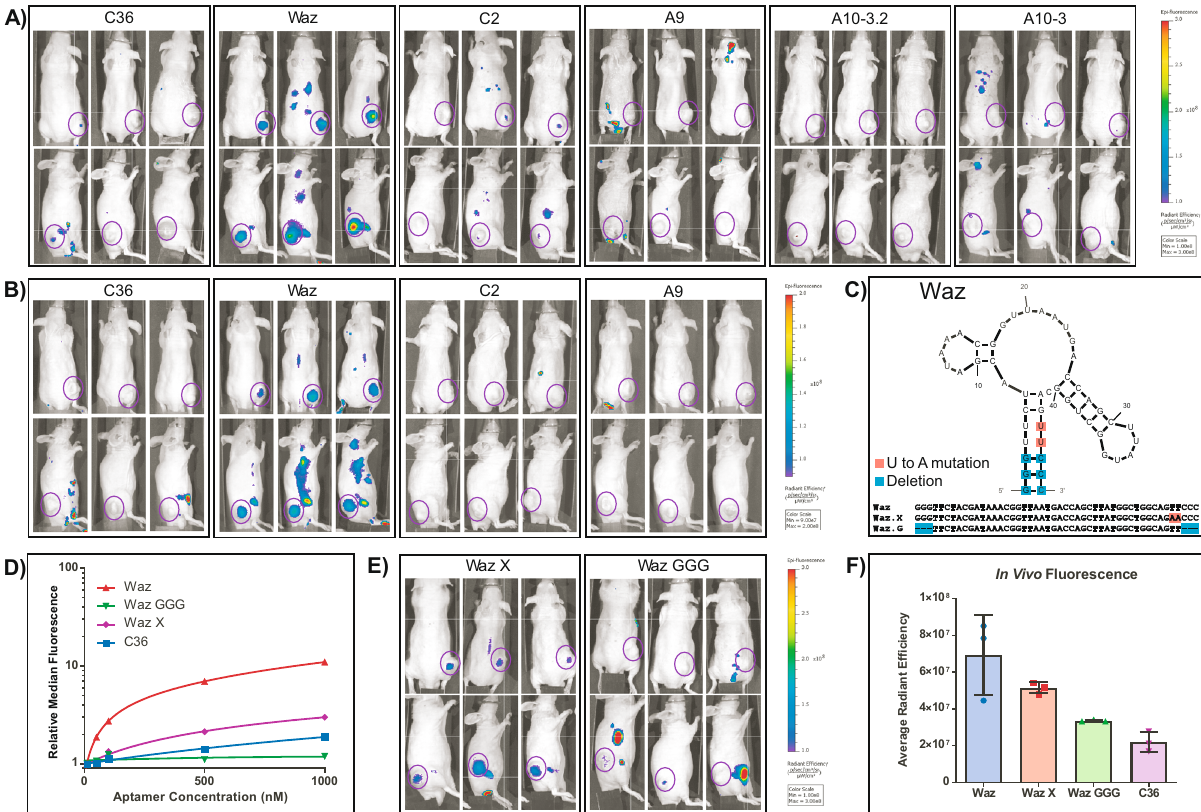
Fig. 5 In vivo imaging and validation of aptamer function. Nude mice bearing subcutaneous xenograft tumors on their right fl ank were injected with 2 nmol of AF750 labeled aptamer ( A ). Dorsal and lateral images of mice bearing 22Rv1 tumors 12 h post injection. The location of the tumor is circled in purple. Injected aptamers are as indicated. Three animals from each cohort ( n = 6) are shown. Additional animals in the cohorts can be found in Supplementary Fig. 188. A time course for a subset of animals ( n = 3) used in this experiment can be found in Supplementary Fig. 189. B Dorsal and lateral images of mice bearing PC3-PSMA tumors 12 h post injection. The location of the tumor is circled in purple. Injected aptamers are as indicated ( n = 3). A time course for a subset of animals used in this experiment can be found in Supplementary Fig. 190. C Predicted secondary structure of Waz and location of base mutations used to generate mutant variants Waz X and Waz GGG. D Relative binding af fi nity of Waz, Waz.X and Waz.GGG on 22Rv1 cells. E Dorsal and lateral images of mice bearing 22Rv1 tumors 12 h post injection. The location of the tumor is circled in purple. F Quantitation of fl uorescence signal within tumors following injection with Waz, Waz.X, Waz.GGG, or C36 ( t = 12 h, n = 3). Data represents the mean ± SD. Source data are provided as a Source Data fi